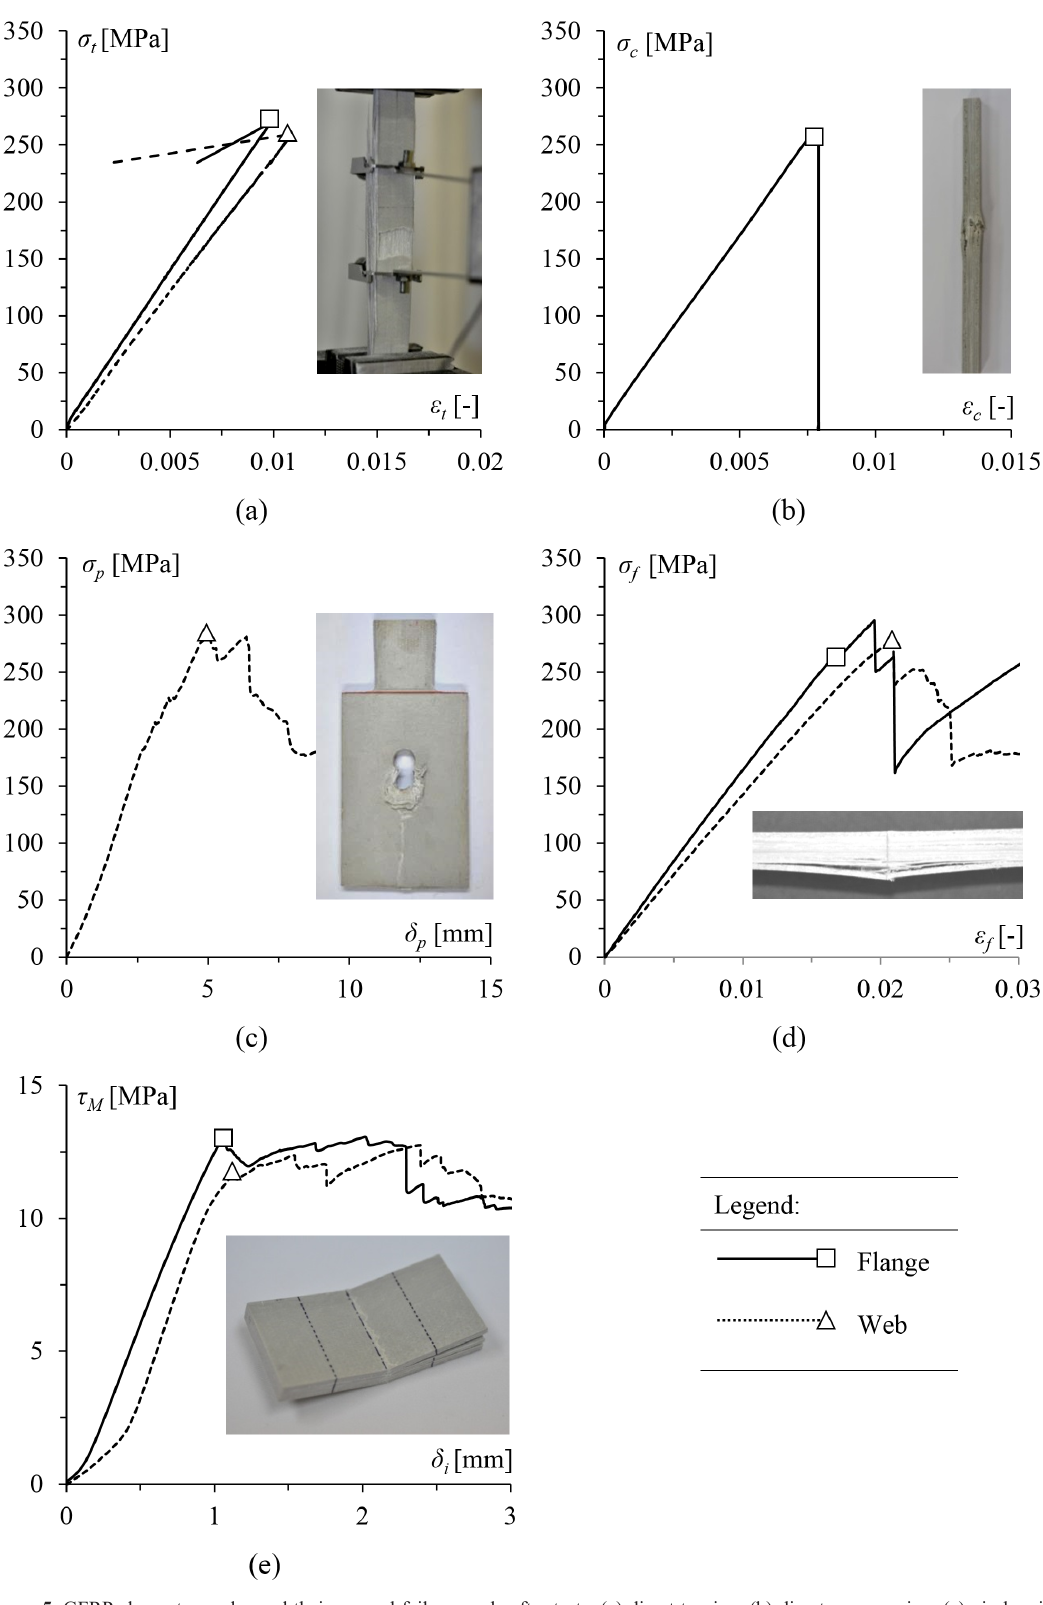
Figure 5. GFRP element samples and their general failure mode after tests: (a) direct tension, (b) direct compression, (c) pin-bearing pushed-out, (d) two-point flexural bending and (e) interlaminar